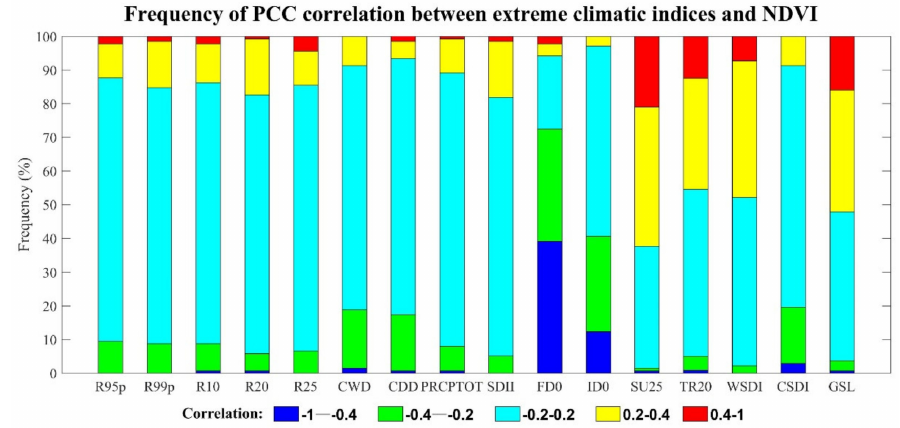
Figure 15. Percentages of Pearson correlation coe ffi cients of NDVI with extreme climate indices over the Loess Plateau